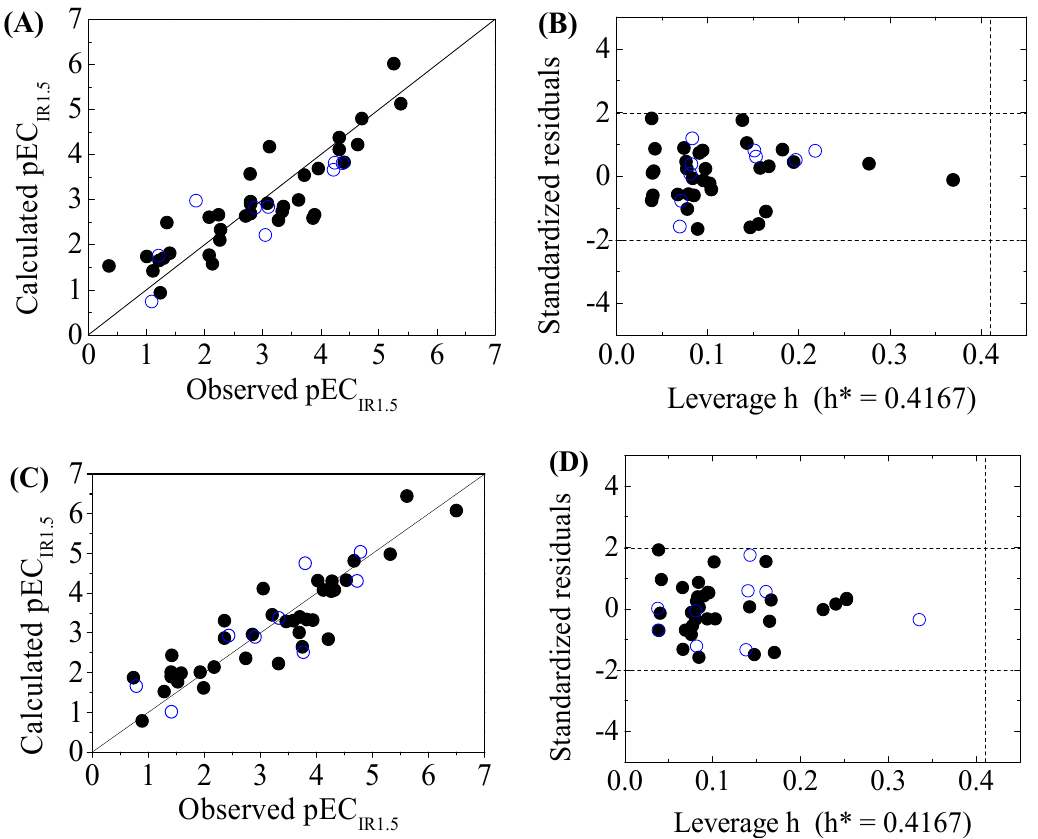
Figure 2. Scatter plot of observed versus calculated pEC IR1.5 (( A ) for GSH+ and ( C ) for GSH − ) and the Williams plot (( B ) for GSH+ and ( D ) for GSH − ) of the final model for 45 disinfection byproducts. “ ● ”: training set, “ ○ ”: test set.